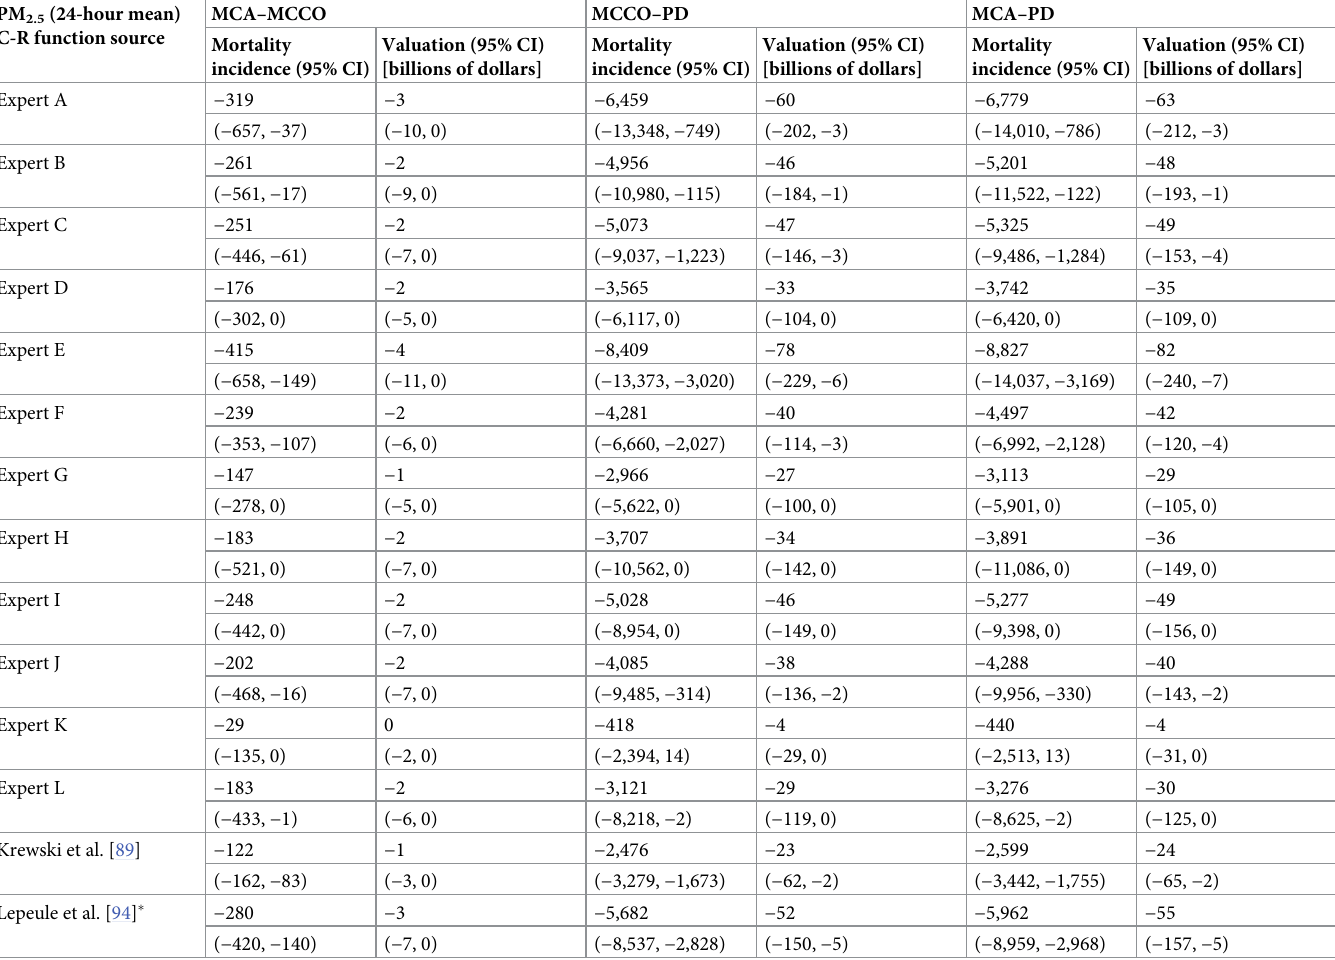
Table 2. PM 2.5 -related mortality results summed regionally for July exposure and displayed for each scenario